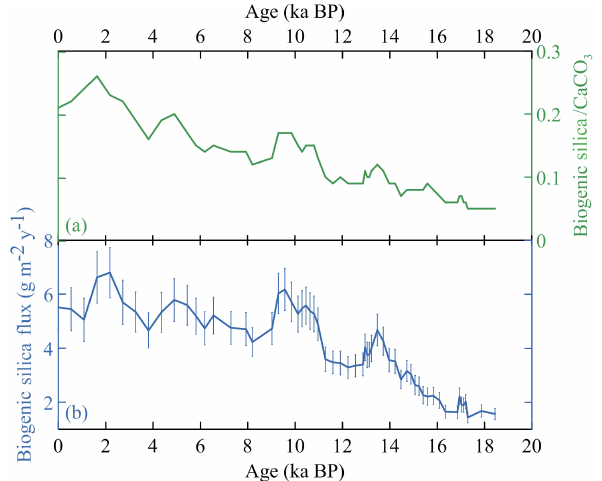
Figure 9. A comparison of the biogenic silica flux with the silica to carbonate ratio in the SS-4018 sediment core. Synchronous changes in both parameters indicate the dominance of the biogenic silica flux over the ratio.